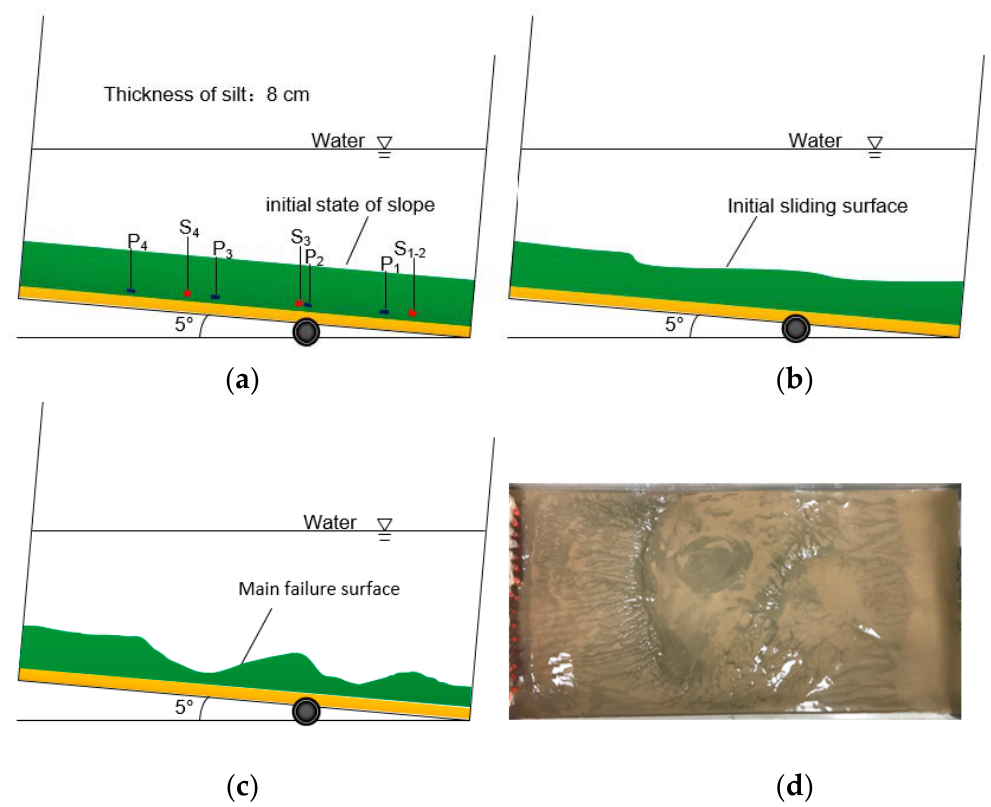
Figure 13. Profile and plan views of the slope after failure in Model 8-5. ( a ) Before Angle adjustment; ( b ) After the Angle adjustment; ( c ) After the destruction; ( d ) top view of end of experiment.